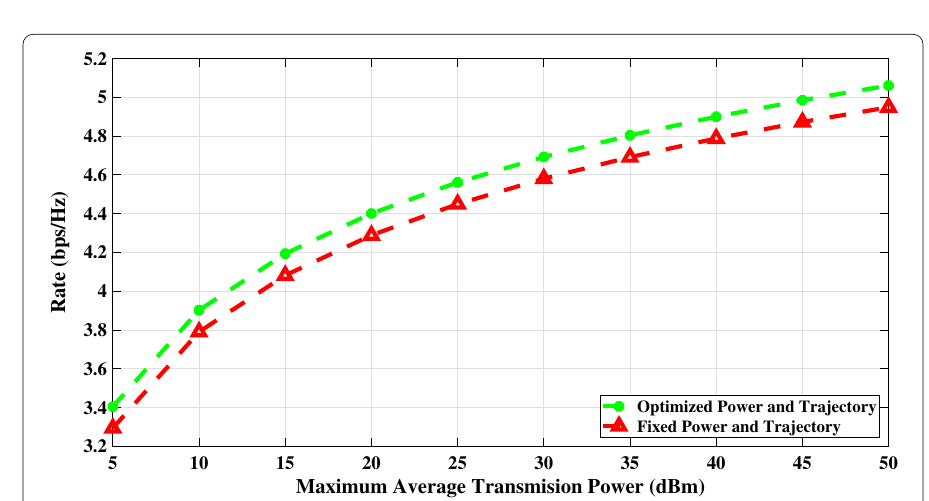
Fig. 12 Information rate with two power and trajectory